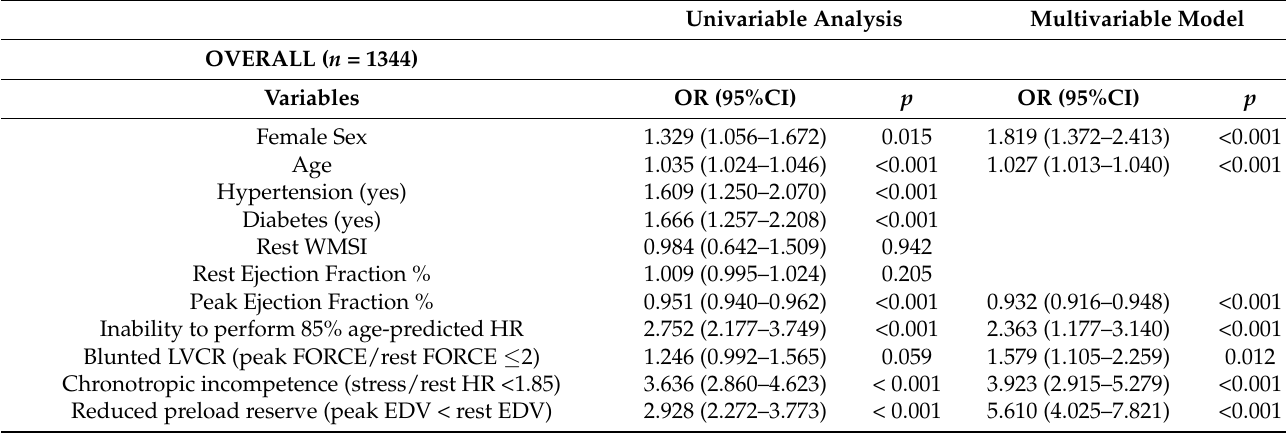
Table 3. Univariable and multivariable binary logistic regression analysis of factor associated with abnormal. Cardiac index